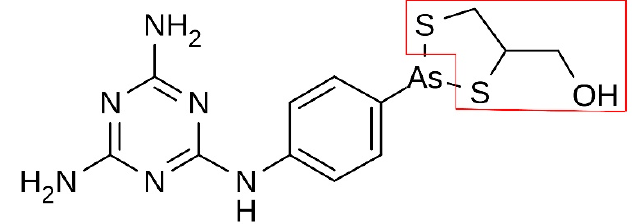
Figure 6. Chemical structure of melarsoprol. The red line indicates the dimercaprol ligand.